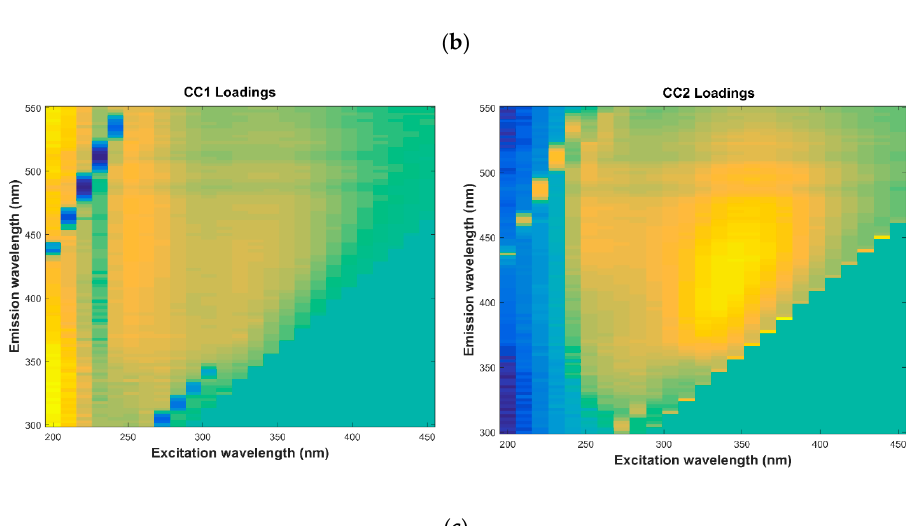
Figure 7. ComDim results on CC1 and CC2: ( a ) scores, ( b ) saliences and ( c ) loadings.